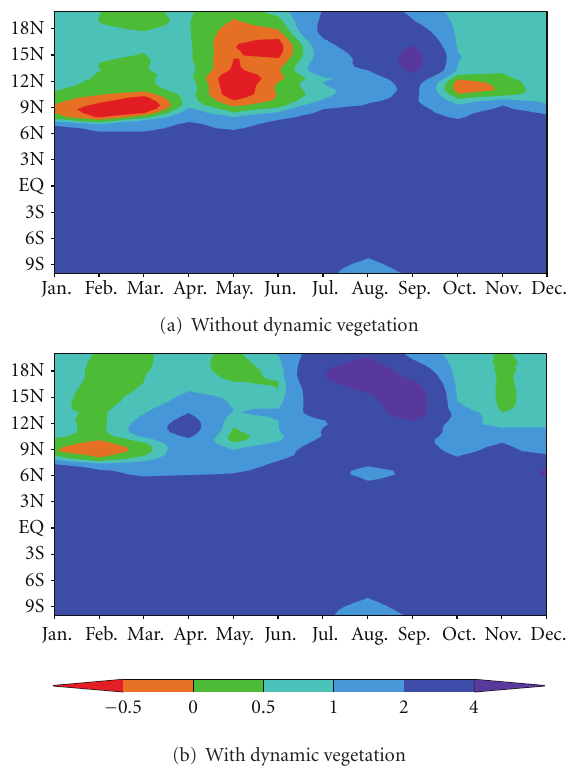
Figure 7: Monthly mean changes in surface specific humidity (g/kg), averaged over 5 ◦ W-5 ◦ E.